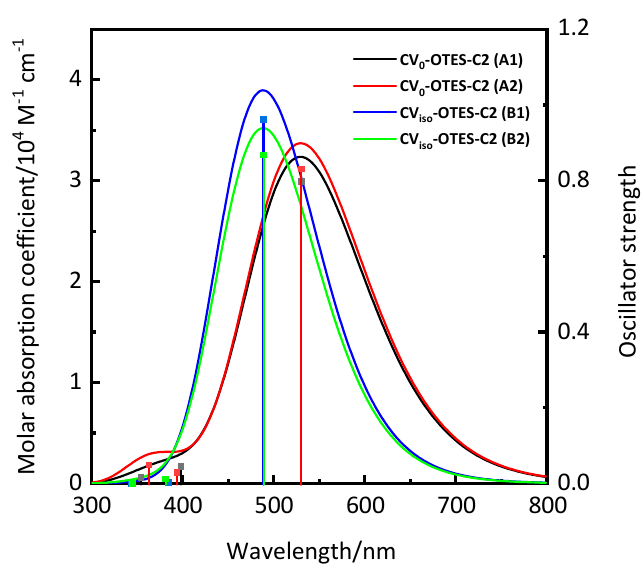
Figure 4. Simulated UV-visible absorption spectra of CV 0 –OTES–C2 and CV iso –OTES–C2 using conductor-like polarized continuum model (CPCM) in ethanol (EtOH). Calculations were carried out at the TD-B3LYP/6-31+G* level of theory. Vertical lines indicate the calculated oscillator strengths. Table 2. Calculated maximum absorption peaks ( λ max ), molar absorption coefficients ( ε ), energies of singlet excited states ( E S1 ), oscillator strengths ( f ) and light-harvesting efficiencies (LHE) of CV 0 – OTES–C2 and CV iso –OTES–C2.